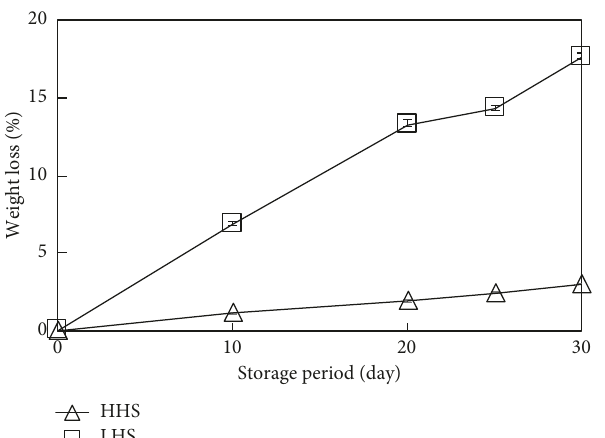
Figure 1: Weight loss of “Shine Muscat” bunches during storage. HHS: high storage humidity sections; LHS: low storage humidity sections. Error bar shows standard error ( n �